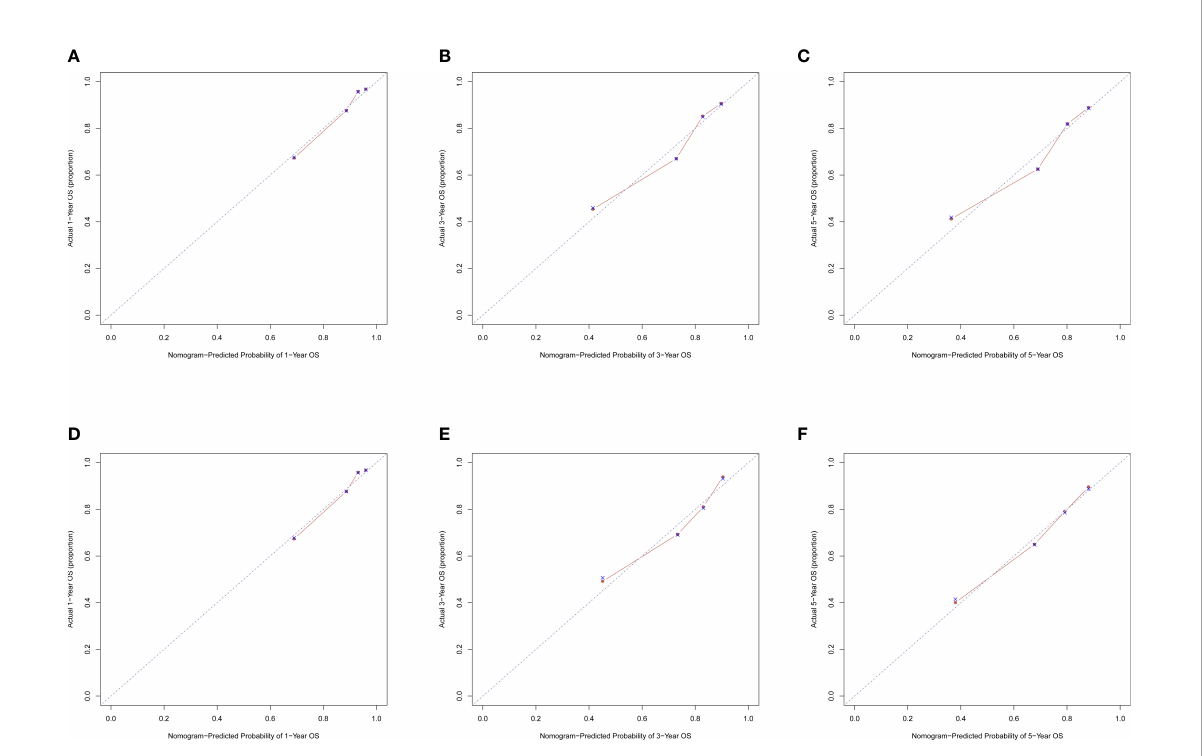
FIGURE 4 Calibration curves of nomogram. (A) For 1-year CSS in training cohort; (B) For 3-year CSS in training cohort; (C) For 5-year CSS in training cohort; (D) For 1-year CSS in validation cohort; (E) for 3-year CSS in validation cohort; (F) for 5-year CSS in validation